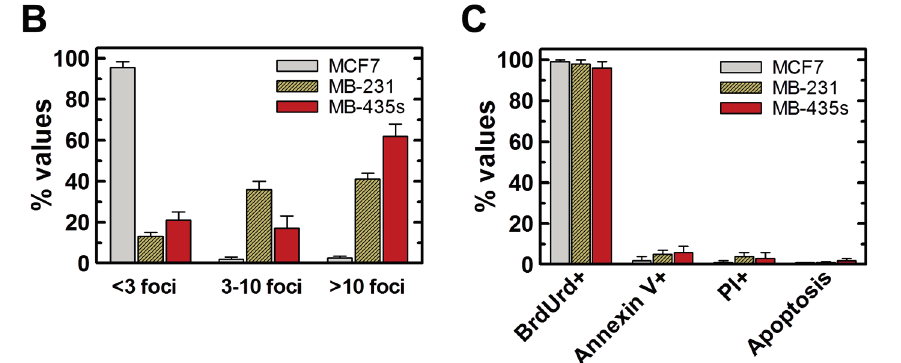
Figure 6. Spontaneous levels of γ H2AX foci in the indicated breast cancer cell lines. ( A ) Immunofluorescence images showing constitutive γ H2AX foci. Circles mark nuclei with low levels of foci; Scale bar, 10 µm; ( B ) Comparison of these cell lines for the proportion of cells exhibiting the indicated numbers of foci per nucleus. Bars, SE; ( C ) Comparison